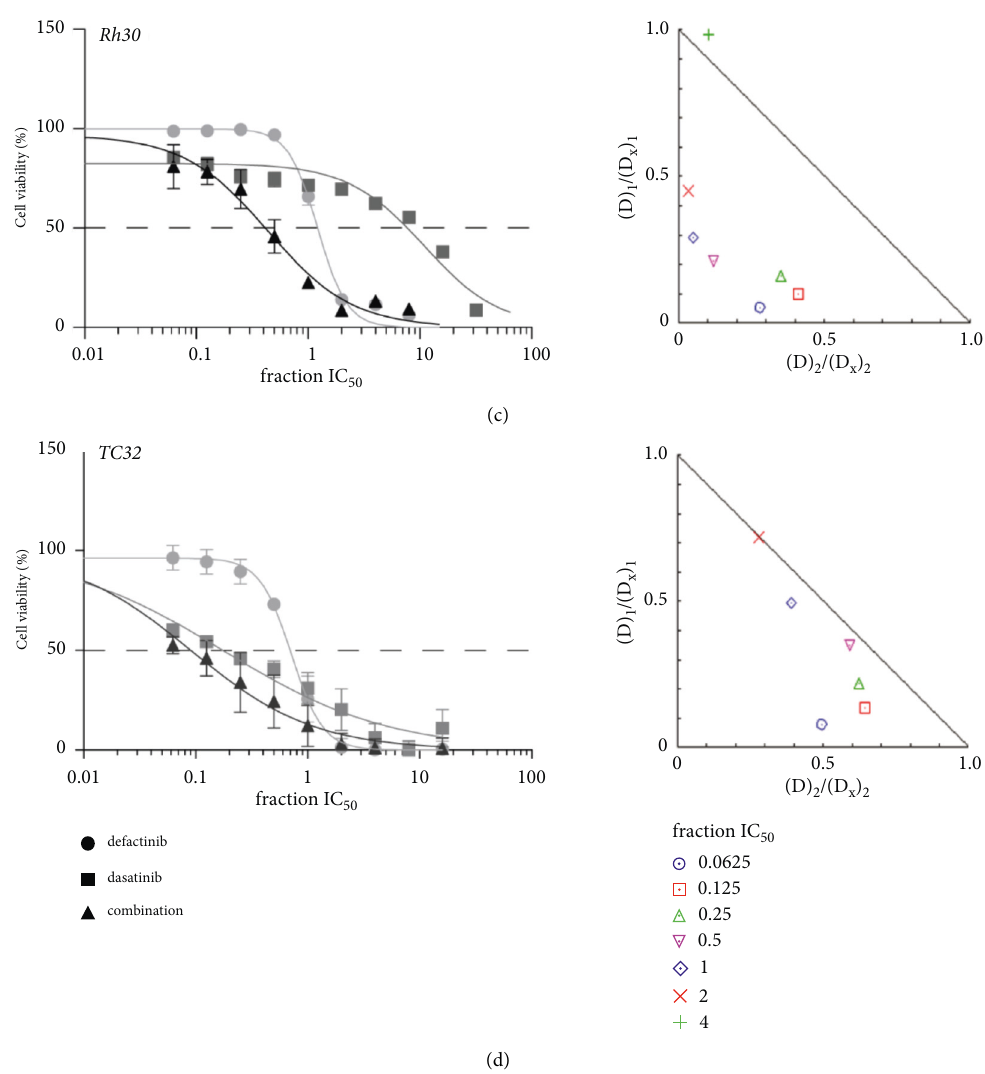
Figure 4: Cell viability and drug synergy following defactinib and dasatinib combination treatment in DSRCT, ERMS, ARMS, and ES cell lines. (a–d) Cell viability (%) following defactinib and dasatinib simultaneous, constant-ratio combination treatment in the JN-DSRCT-1 (a), RD (b), Rh30 (c), and TC32 (d) cell lines alongside the corresponding isobologram, representing the level of drug synergy. The X- and Y - axes of the isobologram represent the fraction of the portion of the drug in the combination treatment (D1 +D2) necessary to reduce an x% cell viability (D1/2) divided by the dose necessary as a single agent to generate a reduction of a similar x% cell viability (DX)1/2. D1 � defactinib, D2 � dasatinib. The line connecting the X- and Y -axes represents an additive effect (CI � 1). Points left of the line are considered a synergistic effect (CI <